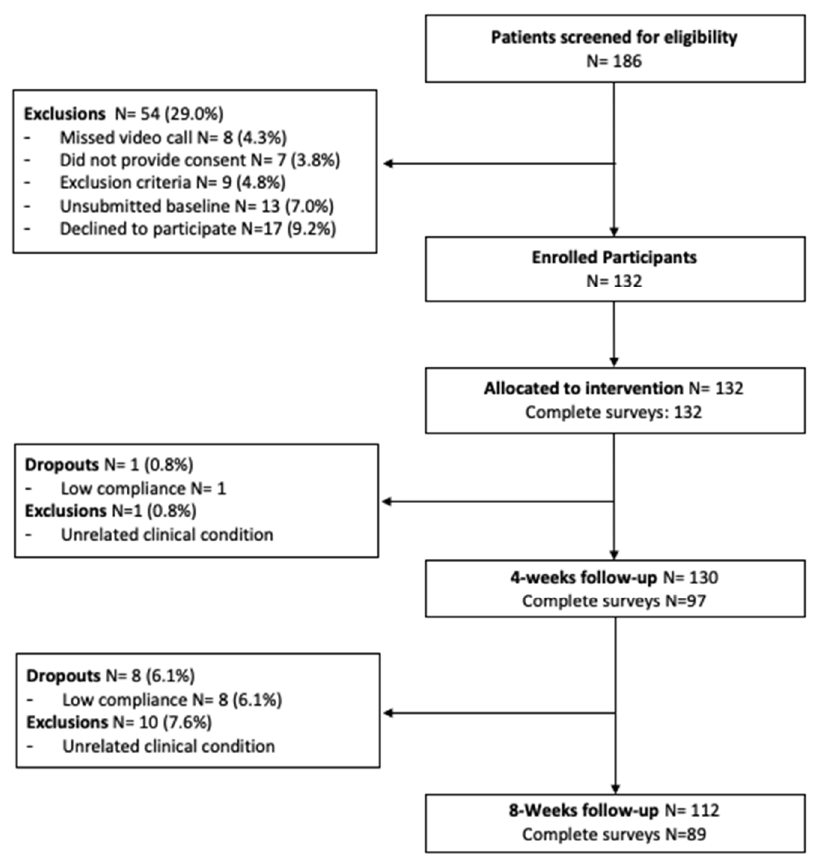
Figure 2. Study flow diagram.